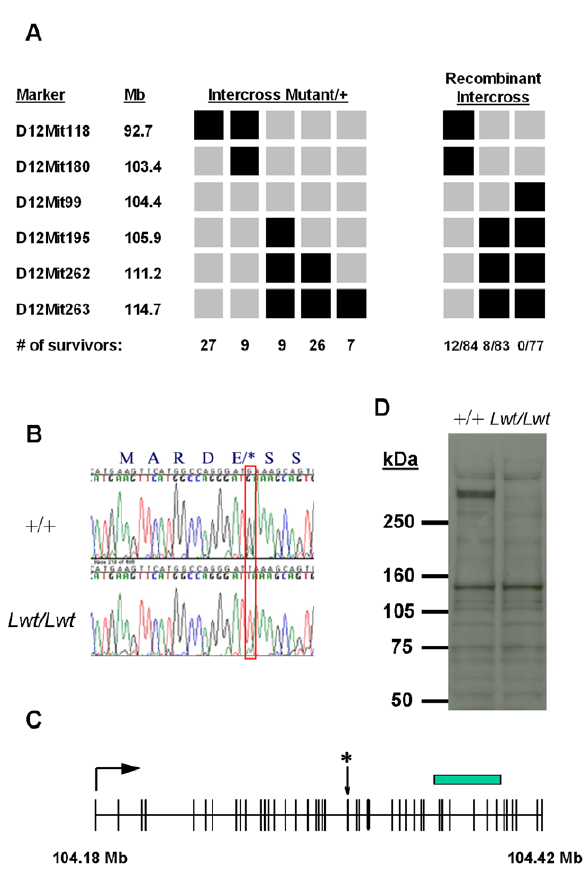
Figure 3. Positional cloning of the unc-79 Lightweight mutation. (A) Haplotype analysis of surviving animals from Mutant/ + intercross. Mutant/ + animals were intercrossed (Left plot) and animals that survived were genotyped across the distal portion of mouse chromosome 12. Black boxes indicate homozygosity for the mutagen- ized D2 strain and grey boxes indicate either homozygosity for the B6 strain or heterozygosity for B6 and D2. Numbers of surviving animals with a particular haplotype are indicated at the bottom. Three different male carriers (Right plot) with the indicated haplotypes were crossed to Mutant/ + females, and the ratio of surviving progeny/total number born was monitored. Both crosses indicate that the lethality maps to a region between D12Mit180 and D112Mit195. Note that survival of animals born to Mutant/ + females is lower than expected for unknown reasons. (B) Sequence analysis of + / + and Lwt / Lwt DNA. Note the G R T transversion in Lwt/Lwt which changes a glutamic acid residue to a premature stop codon. (C) Exon structure of unc-79 gene (AB257853) with position of Lwt point mutation indicated by (*). Genome coordinates were determined using NCBI Build 37. The C-terminal portion of the protein used to generate the antibody is indicated by a rectangle. (D) Western analysis of + / + and Lwt / Lwt P0 whole brain lysates. Note the absence of unc-79 protein in Lwt/Lwt homozygotes at , 300